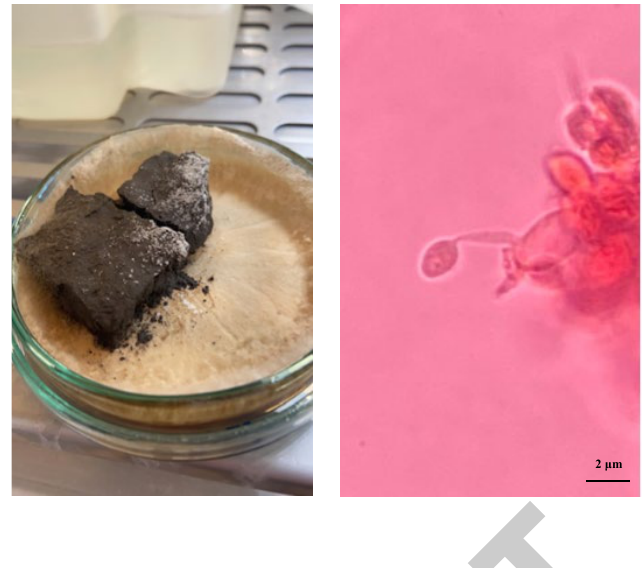
Photo 1 . Perfect stages of Rhizoctonia solani . Left - fru i ting visible on the soil surface . Right - basidium and basidiospore of Rhizoctonia solani - dyed with safranine 0; ( × 400) Heterokaryon formation. Single basidiospore isolates (SB Is ) served as progenies and parental strains to produce potential heterokaryons (H s ). Potential Hs were obtained through cultural pairing of SB Is (parental strains) and their cleavage from the contact sites of the two